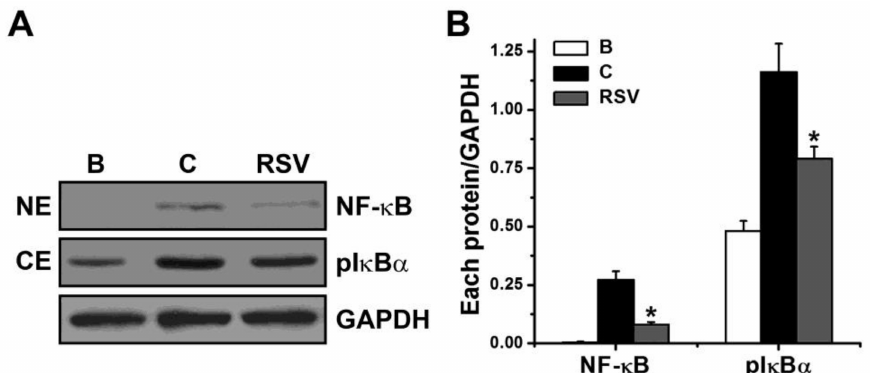
Figure 3. Effects of RSV on the activation of NF- κ B and phosphorylation of I κ B α . ( A ) Each protein was analyzed with Western blot analysis. Representative immunoblots are shown. ( B ) Each band was quantitated by densitometry. NE, nuclear extract; CE, cytoplasmic extract; B, PBS-added group; C, PBS plus PMACI-added group. * indicates p < 0.05 versus the control (PBS plus PMACI) group.